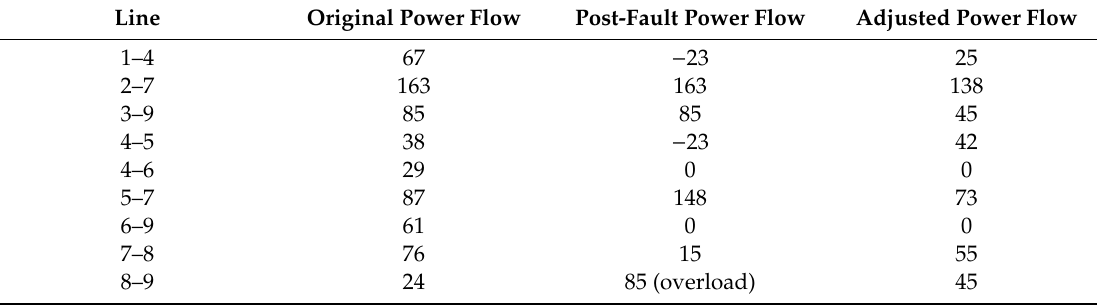
Figure 6. The new stable state of CPPS after the bus fault. Table 2. The power flow transferring under bus fault